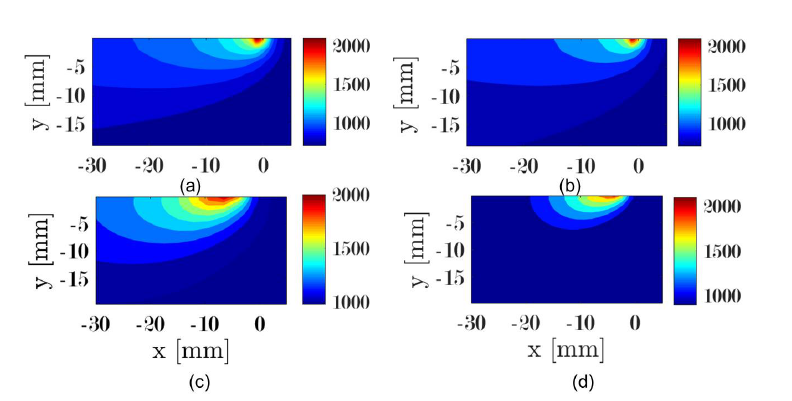
Figure 4. Comparison of analytical and numerical works ( ◦ C). ( a ) analytical model ( P = 600 W, V = 0.2 m/min); ( b ) analytical work ( P = 600 W, V = 0.4 m/min); ( c ) numerical model ( P = 600 W, V = 0.2 m/min); ( d ) numerical work ( P = 600 W, V = 0.4